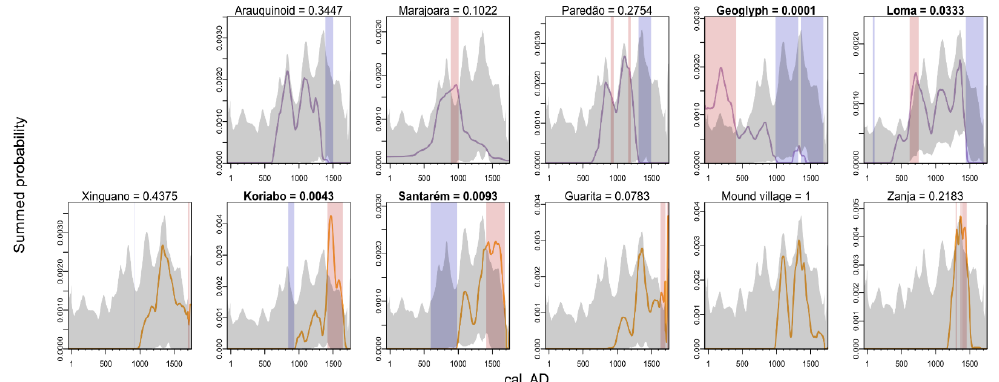
Figure 2. Permutation test of cultural phases in Amazonia. Envelopes are based on 10000 permutations of the dataset. Phase names in bold possess statistically significant divergences from the Amazonian pattern (Geoglyphs, Lomas, Santarém, Koriabo). Locally significant anomalies are in red (positive) and blue (negative).